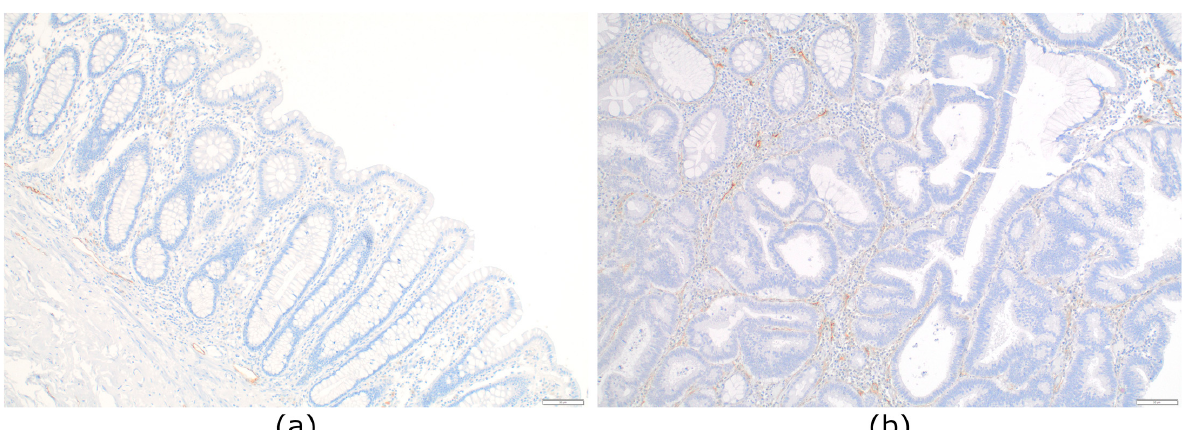
Table 2. Clinicopathologic characteristics of pTis colorectal carcinomas according to lymphatic ves- sel density.